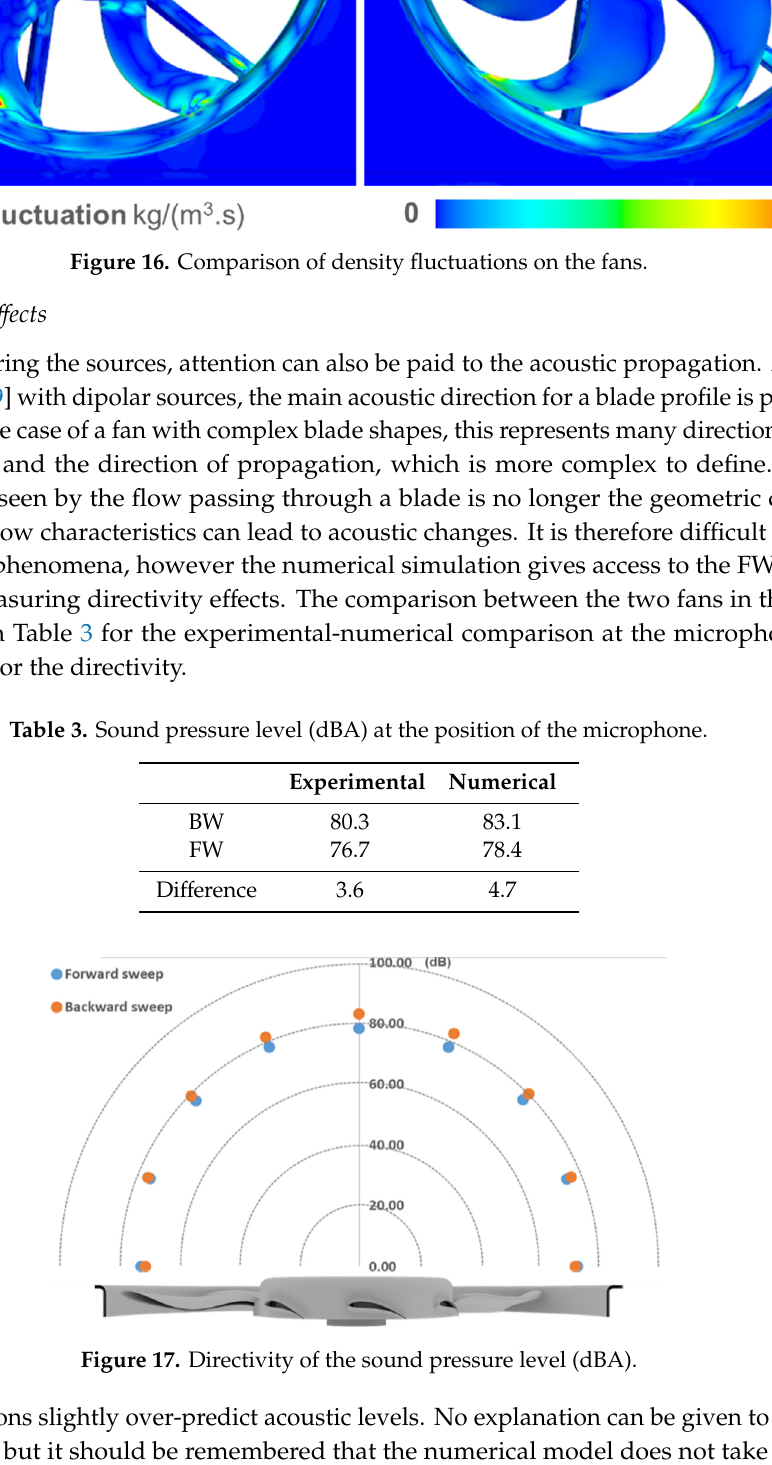
Figure 17. Directivity of the sound pressure level (dBA) .